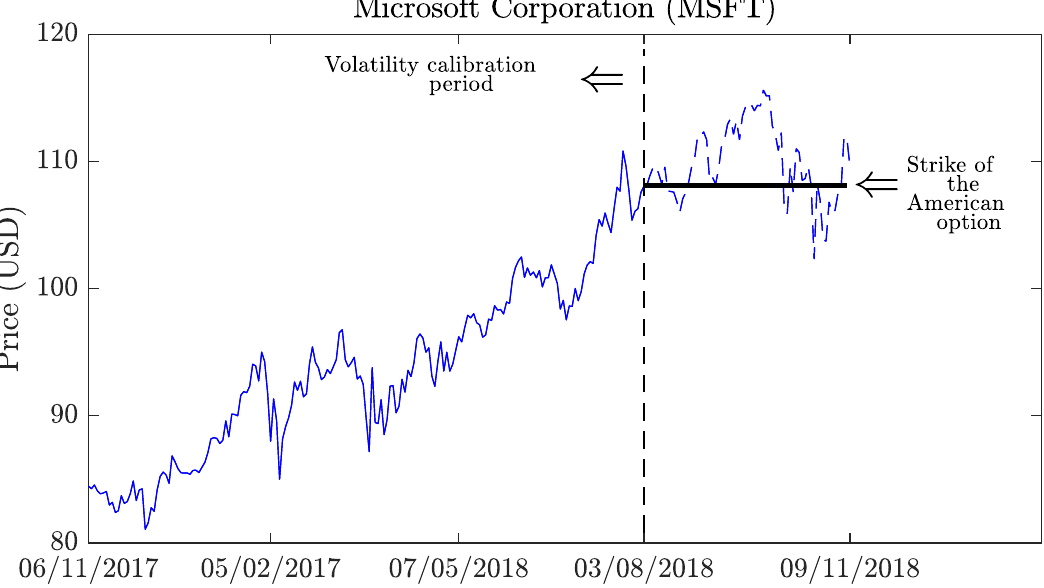
Figure 8. Daily closing prices of the Microsoft Corporation’s stock. Data spans from 6.11.2017 to 9.11.2018. Vertical dashed line indicates the end of volatility calibration period. Option prices are calculated based on the volatility and the stock’s price on 3.08.2018.